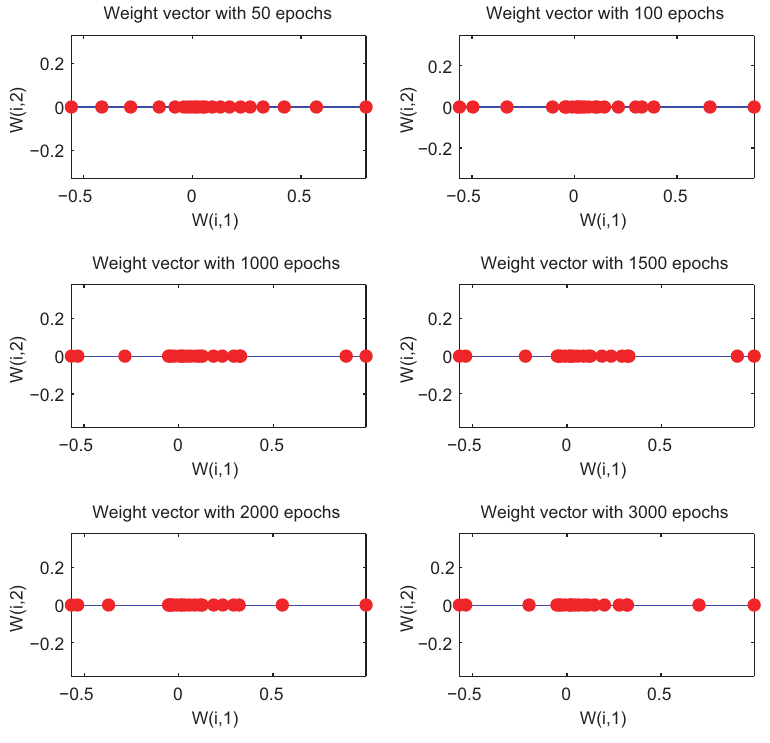
Figure 4. SOM Weight